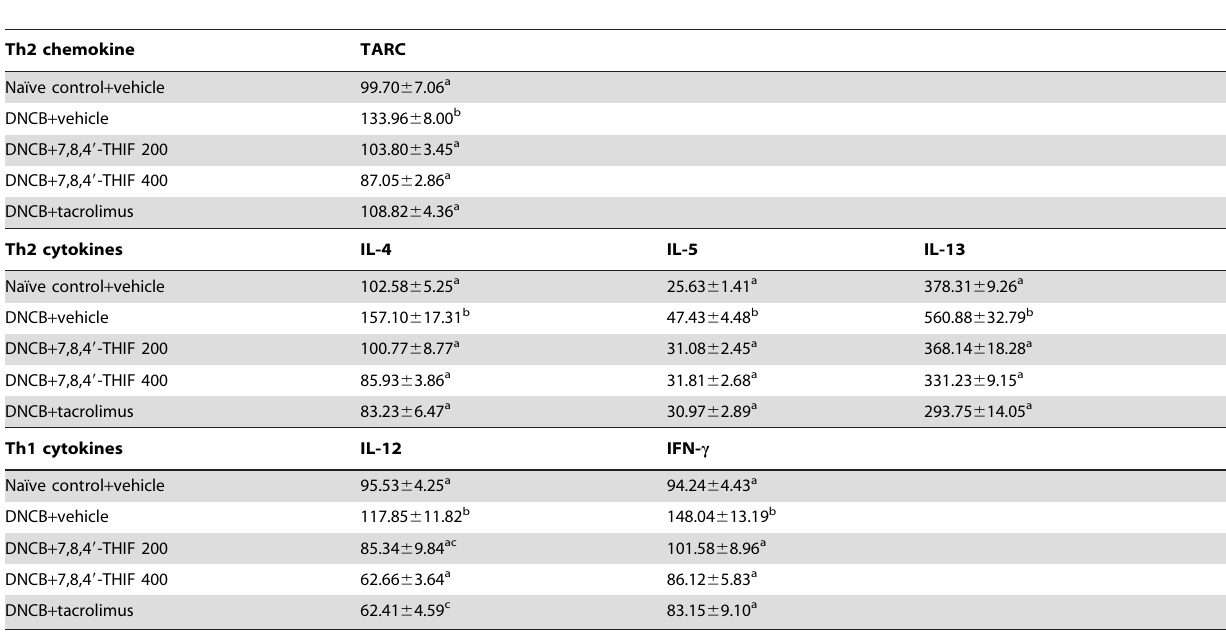
Table 1. Effects of 7,8,4 9 -THIF on DNCB-induced increase in chemokine TARC and Th2 and Th1 cytokines in NC/Nga mice.